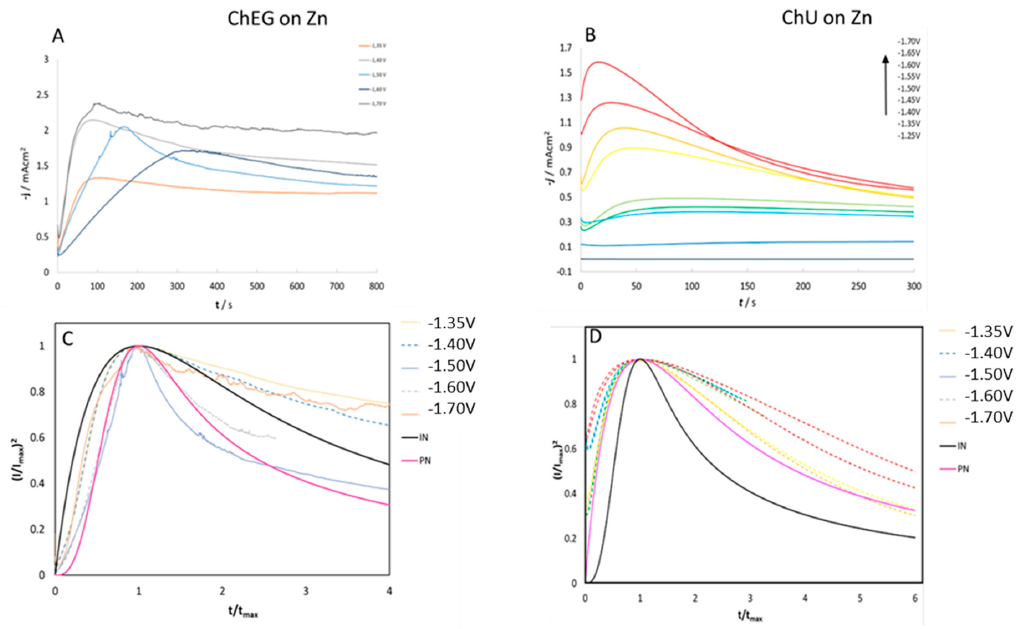
Figure 8. ( A , B ): Chronoamperograms for 0.3 M ZnSO 4 in ChEG ( A ) and ChU ( B ) using a Zn electrode at 25 °C. ( C , D ): Normalized experimental curves of Panels ( A , B ), plotted together with theoretical curves for progressive (solid pink line) and instantaneous nucleation (solid black line) according to the model of [32,33].